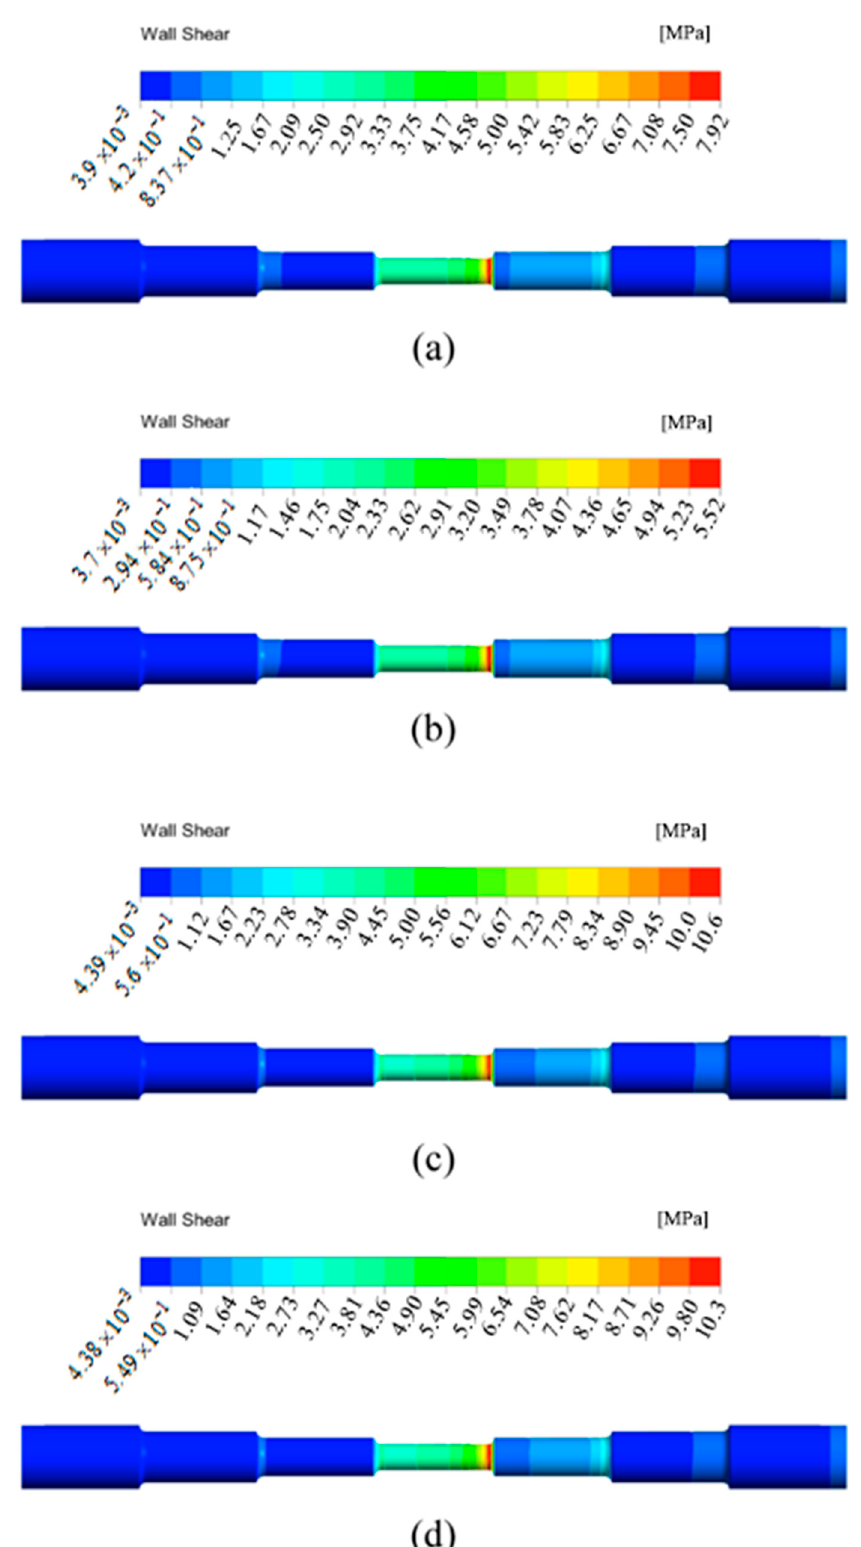
Figure 8. Wall shear stress distribution of the seven-order variable-diameter pipe obtained under the four sets of experiment parameters. ( a ) Under the experiment parameter of 30 m/s, 15 V, and 500 μ m; ( b ) Under the experiment parameter of 30 m/s, 45 V, and 500 μ m; ( c ) Under the experiment parameter of 50 m/s, 45 V, and 500 μ m; ( d ) Under the experiment parameter of 50 m/s, 45 V, and 1200 μ m.